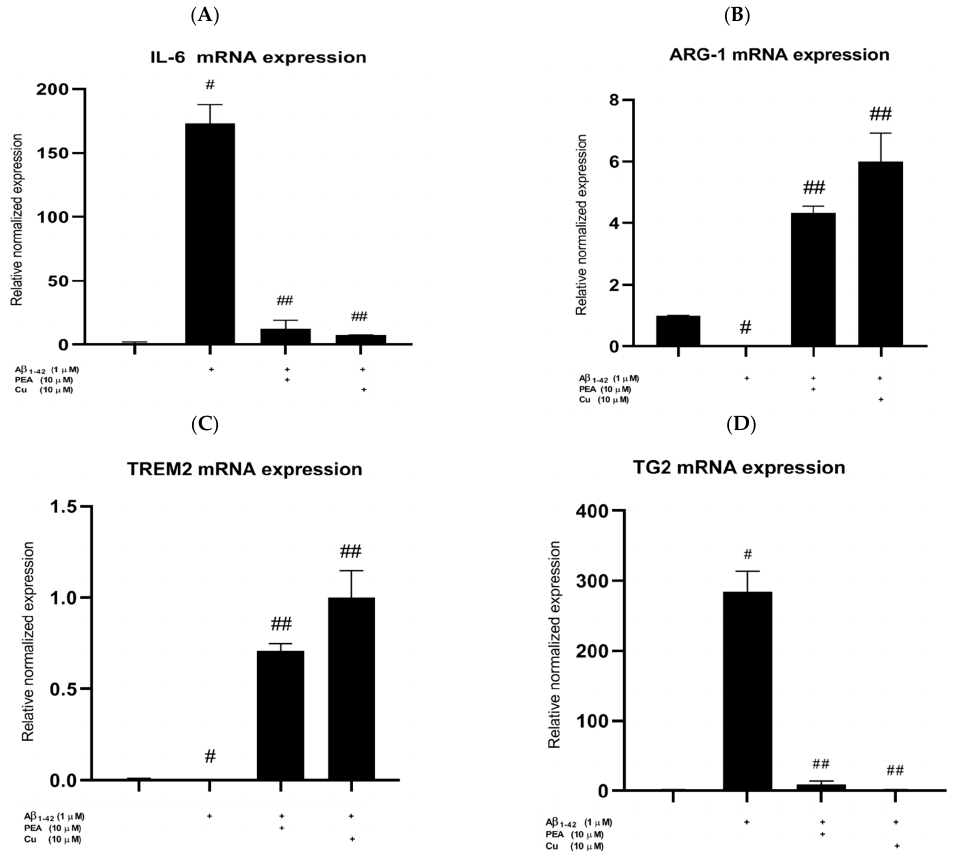
Figure 6. Real Time-PCR was performed to measure the RNA expression levels of TG2 ( D ), inflam- matory ( A ) or neuroprotective ( B , C ) markers after 24 h treatment. BV2 cells were pre-treated with the indicated concentrations of PEA or curcumin (Cu), followed by treatment with A β 1-42 (1 µ M for 24 h). Data are shown as the mean ± SD of three independent experiments. # p value < 0.05 compared with control group. ## p < 0.05 compared with A β 1-42 group.